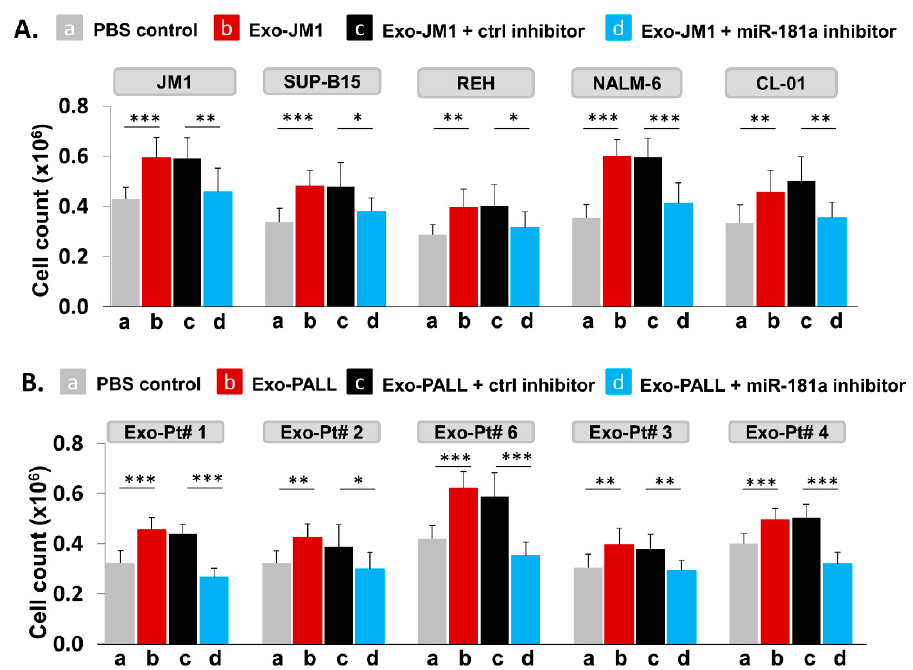
Figure 7. Leukemia derived-exosomal miR-181a silencing reverses exosome-induced cell proliferation. ( A ) Silencing of miR-181a in Exo-JM1 (CM) impairs cell proliferation: Indicated cells were treated with (a) PBS, (b) Exo-JM1, (c) Exo-JM1 + control inhibitor, (d) Exo-JM1 + miR-181a inhibitor (1.0 µ M) for cell proliferation assay. Cell proliferation was observed after treatment with wild type Exo-JM1 (b) or with Exo-JM1 + control inhibitor (c) while in the Exo-JM1 + miR-181a inhibitor treated group (d), cell proliferation remained at baseline, similar to PBS-treated cells (a). These experiments were repeated in five di ff erent cell lines: JM1, SUP-B15, REH, NALM-6, and CL-01 as indicated. ( B ) Silencing of miR-181a in Exo-PALL (serum) impairs cell proliferation: JM1 cells were treated with (a) PBS, (b) Exo-PALL, (c) Exo-PALL + control inhibitor, (d) Exo-PALL + miR-181a inhibitor in cell